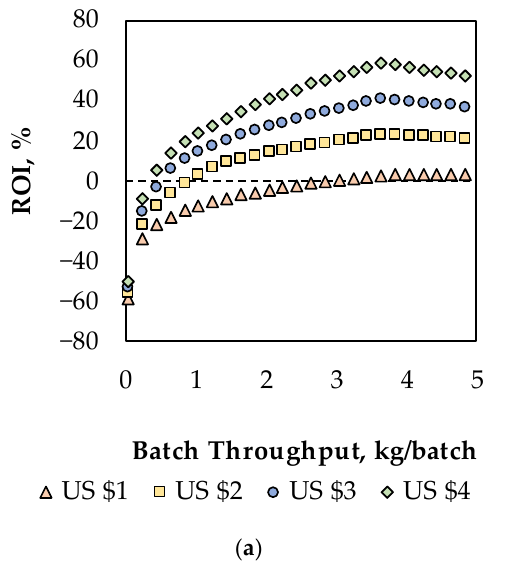
Figure 5. Effect of microbial oil price and batch throughput on ( a ) ROI (%) and ( b ) payback time (years).